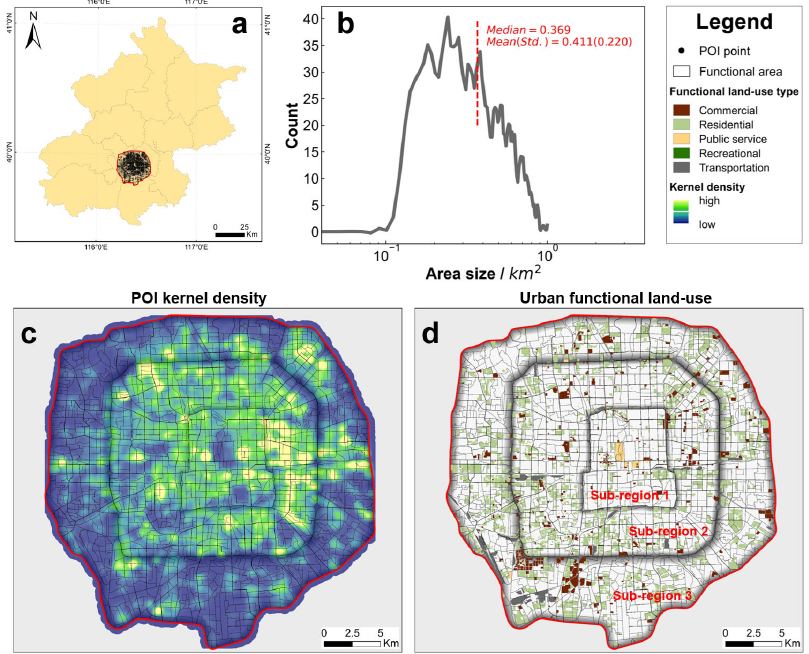
Figure 7. ( a ) Geographical setting of the study region, Beijing, China. The research is carried out within the 5th ring road (marked by the red line); ( b ) histogram statistics of the size for the functional area; ( c ) kernel density distribution of local point of interest (POI) points; and ( d ) the functional land use distribution obtained from the open street map land use dataset, including five categories: commercial, residential, public service, recreational and transportation.